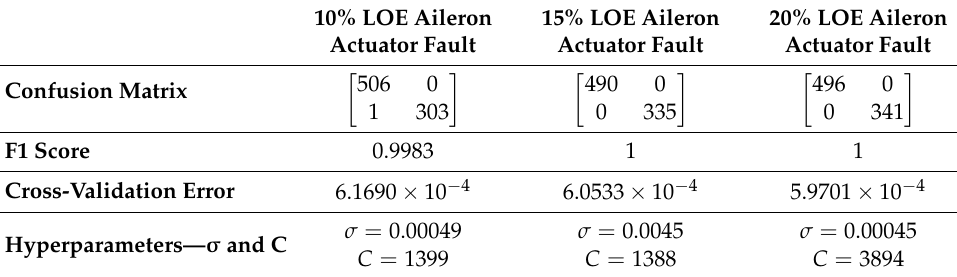
Figure 14. ( a ) Objective function values for different box constraint and sigma values. ( b ) Conver- gence of the objective function. Table 5. Tuned SVM aileron results for LOE fault detection.